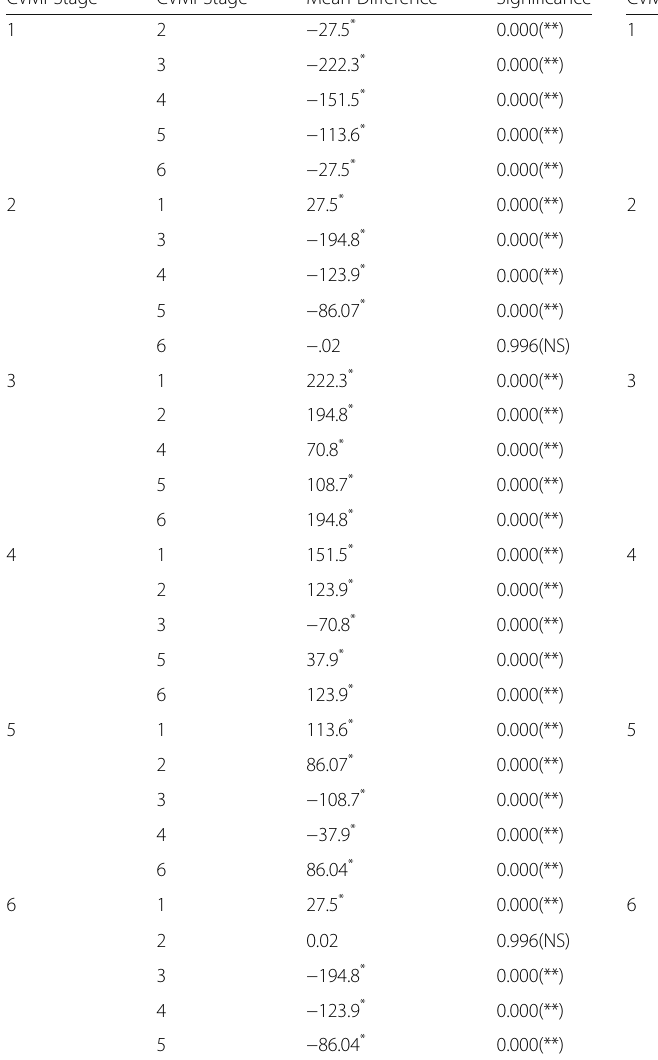
Table 3 The Post-hoc analysis (least significant difference) comparing IGF-1 serum levels for each of the 6 CVMI stages CVMI Stage